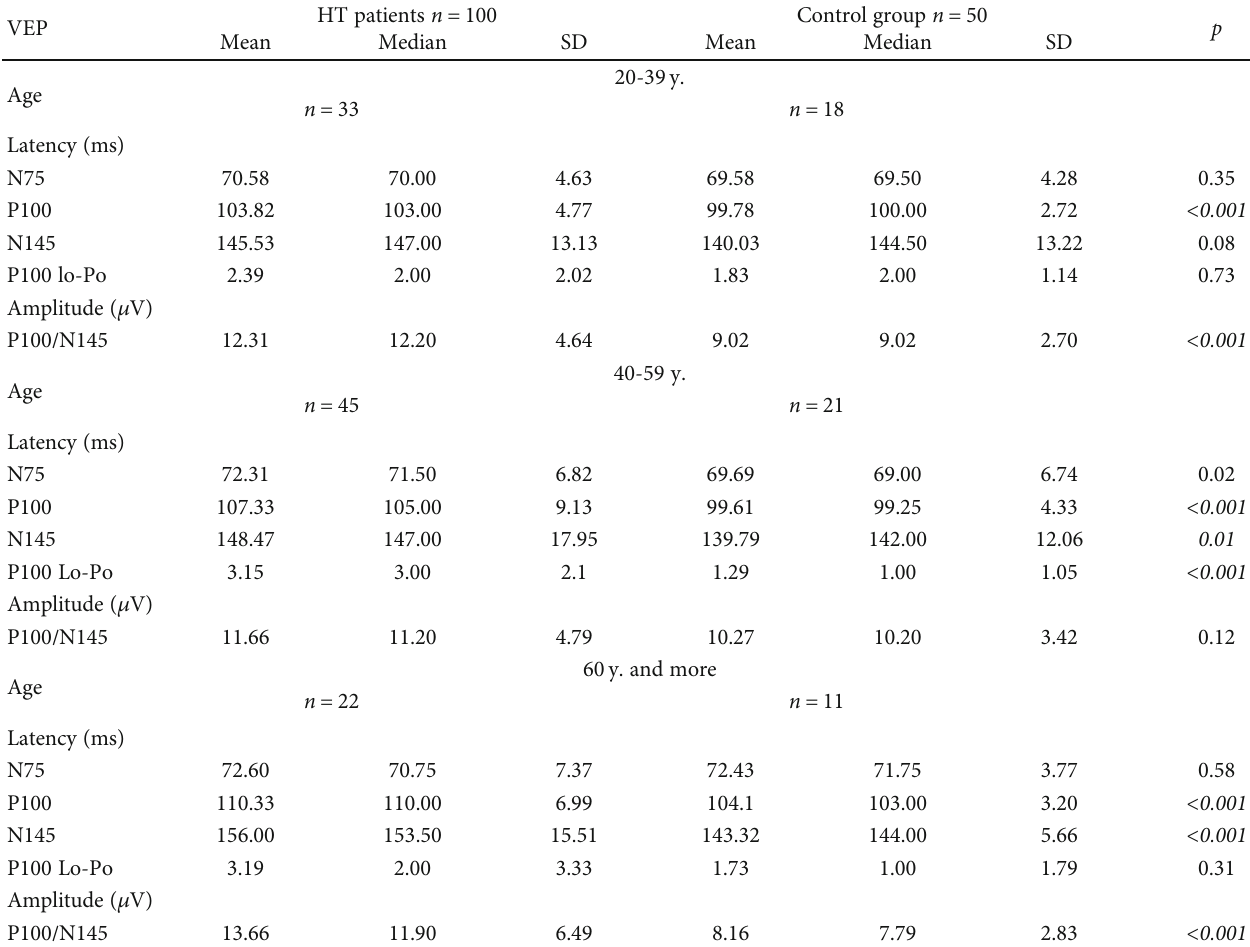
Table 5: Mean values of the latency (ms) and amplitude ( μ V) of VEP parameters in HT patients and in the control group depending on the